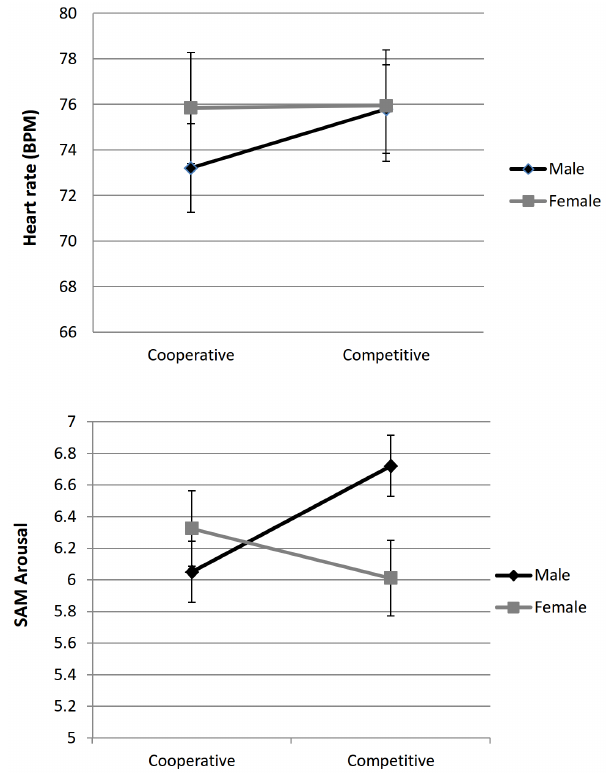
Figure 2. Gender differences in heart rate (left panel), associated with emotional arousal, and self-reported arousal (right panel), across cooperative and competitive modes (Experiment 1). The error bars represent standard